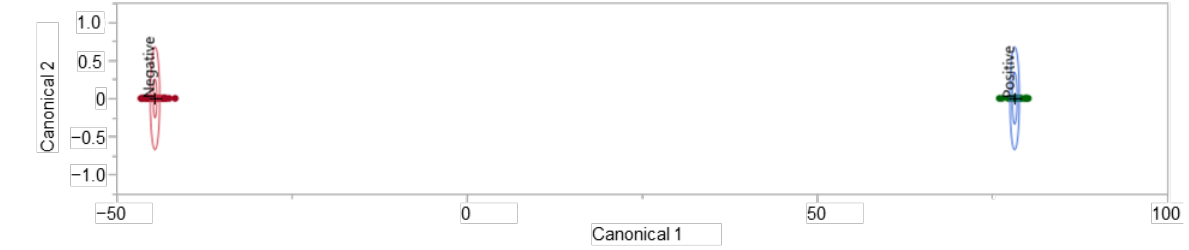
Figure 6. No pets in bed, COVID-19 T-shirt LDA model and model performance.